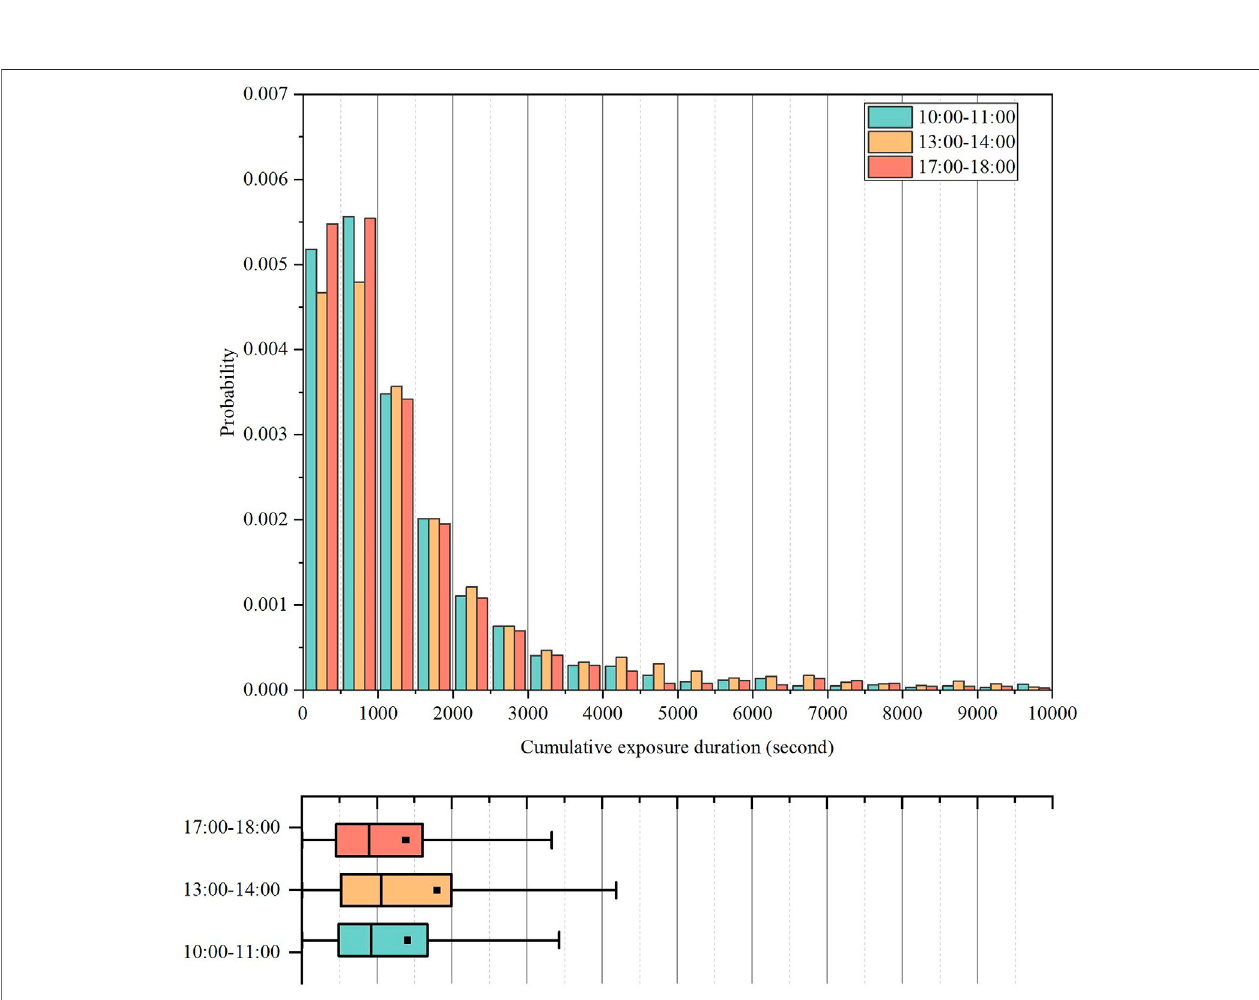
FIGURE 7 | Probability distribution of cumulative exposure duration in different time intervals.